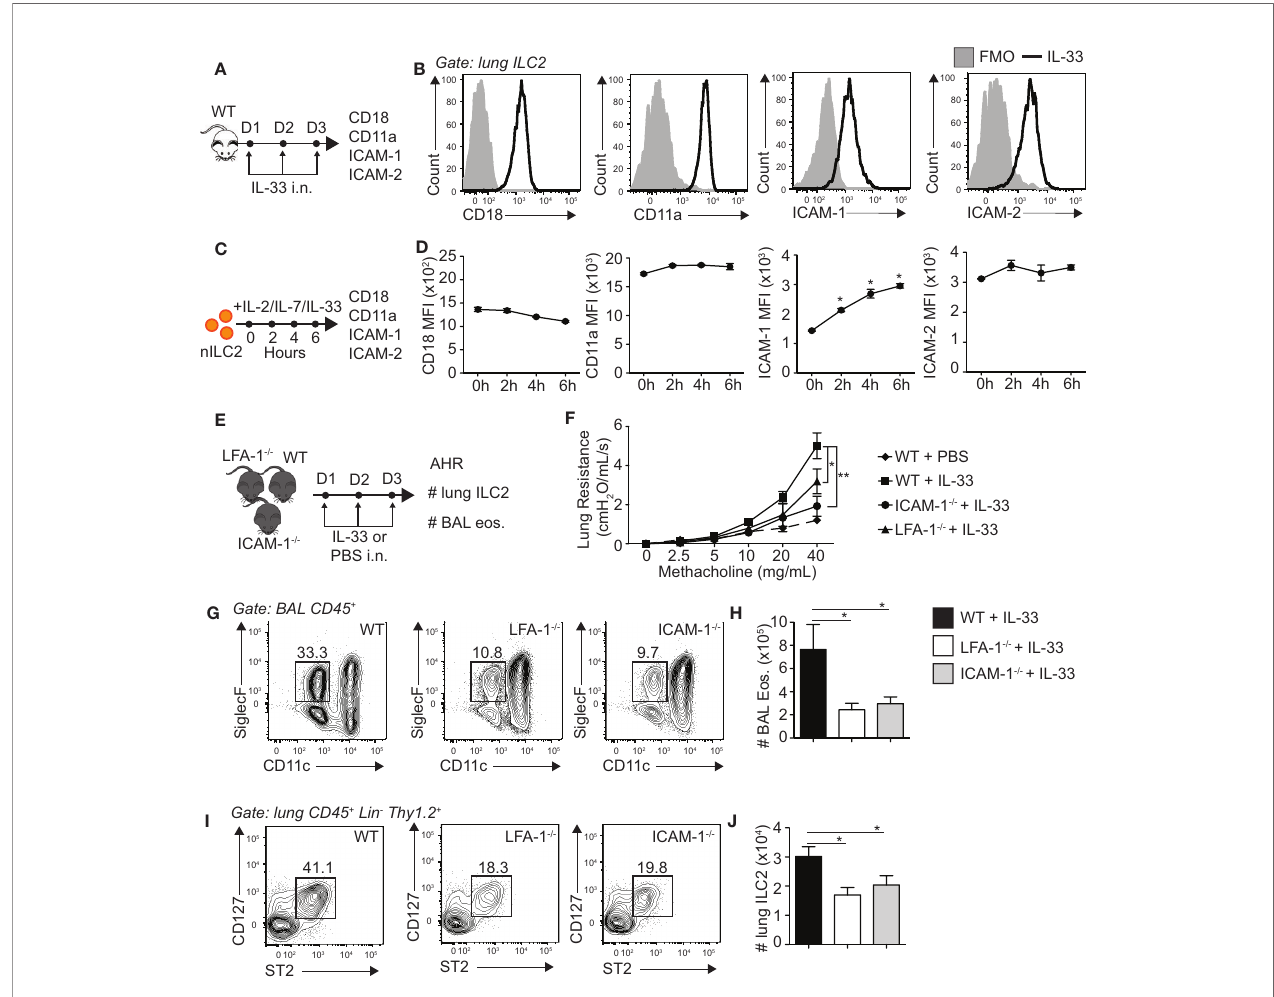
FIGURE 1 | Pulmonary ILC2s express LFA-1, ICAM-1 and ICAM-2 as both ICAM-1 − / − and LFA-1 − / − mice develop attenuated ILC2-dependent AHR. (A) A cohort of BALB/cByJ mice were challenged intranasally on days 1-3 with 0.5 µg rmIL-33 and on day 4 lungs were recovered, processed to single cell suspensions and the expression of CD18, CD11a, ICAM-1, and ICAM-2 on pulmonary CD45 + Lin − Thy1.2 + ST2 + CD127 + ILC2s was analyzed by fl ow cytometry. (B) Representative fl ow cytometry plots of CD18, CD11a, ICAM-1, and ICAM-2 expressions on pulmonary ILC2s following challenge with rmIL-33. Black line: Corresponding marker, Solid Gray: Full Minus One (FMO) staining control. (C) Lungs from a cohort of naïve BALB/cByJ mice were recovered, processed to single cell suspensions and pulmonary naïve ILC2s (nILC2)s were FACS-sorted to a purity of >95%. Pure nILC2s were then cultured (50 × 10 4 /ml) in vitro at 37°C in the presence of rmIL-2 (10 ng/ml), rmIL-7 (10 ng/ml), and rmIL-33 (50 ng/ml) and analyzed for the expression of CD18, CD11a, ICAM-1, and ICAM-2 at the indicated times by fl ow cytometry. (D) Mean Fluorescence Intensity (MFI) of CD18, CD11a, ICAM-1 and ICAM-2 on cultured nILC2s at the indicated times after rmIL-33 stimulation in vitro , presented as MFI ± SEM. (E) Separate cohorts of C57BL/6 (WT), LFA-1 − / − and ICAM-1 − / − mice were challenged intranasally on days 1 to 3 with 0.5 µg rmIL-33. On day 4, airway hyperreactivity (AHR) was analyzed in each cohort as a measure of lung resistance by sequentially nebulizing increasing doses of bronchoconstrictor methacholine in anesthetized/tracheotomized mice on the FinePointe RC system (Buxco Research Systems). Additionally, the numbers ILC2s (CD45 + Lin − Thy1.2 + ST2 + CD127 + ) in the lungs, and eosinophils (CD45 + SiglecF + CD11c − ) in the bronchoalveolar lavage (BAL) fl uid were analyzed by fl ow cytometry. (F) Lung resistance in each cohort of mice in response to increasing doses of bronchoconstrictor methacholine. The dashed line represents WT mice challenged intranasally with PBS as a baseline control for the measure of AHR. (G) Representative fl ow cytometry plots of BAL eosinophils in each cohort and (H) corresponding quantitation presented as the mean number of BAL eosinophils ± SEM. (I) Representative fl ow cytometry plots of pulmonary ILC2s in each cohort and (J) corresponding quantitation presented as the mean number of lung ILC2s ± SEM. Data are representative of three individual experiments with n = 5. *p < 0.05, **p <